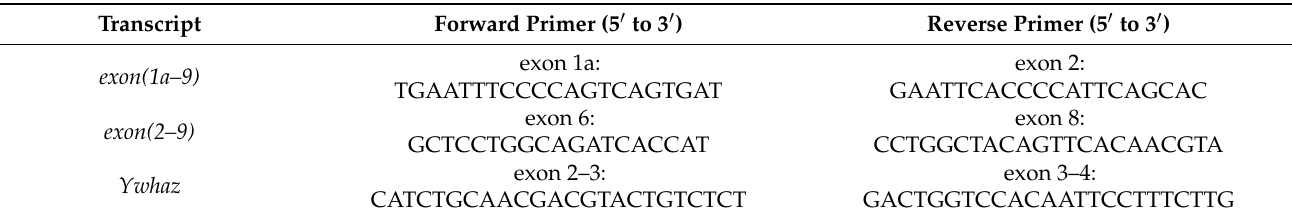
Table 1. Primer sequences for the detection of transcript